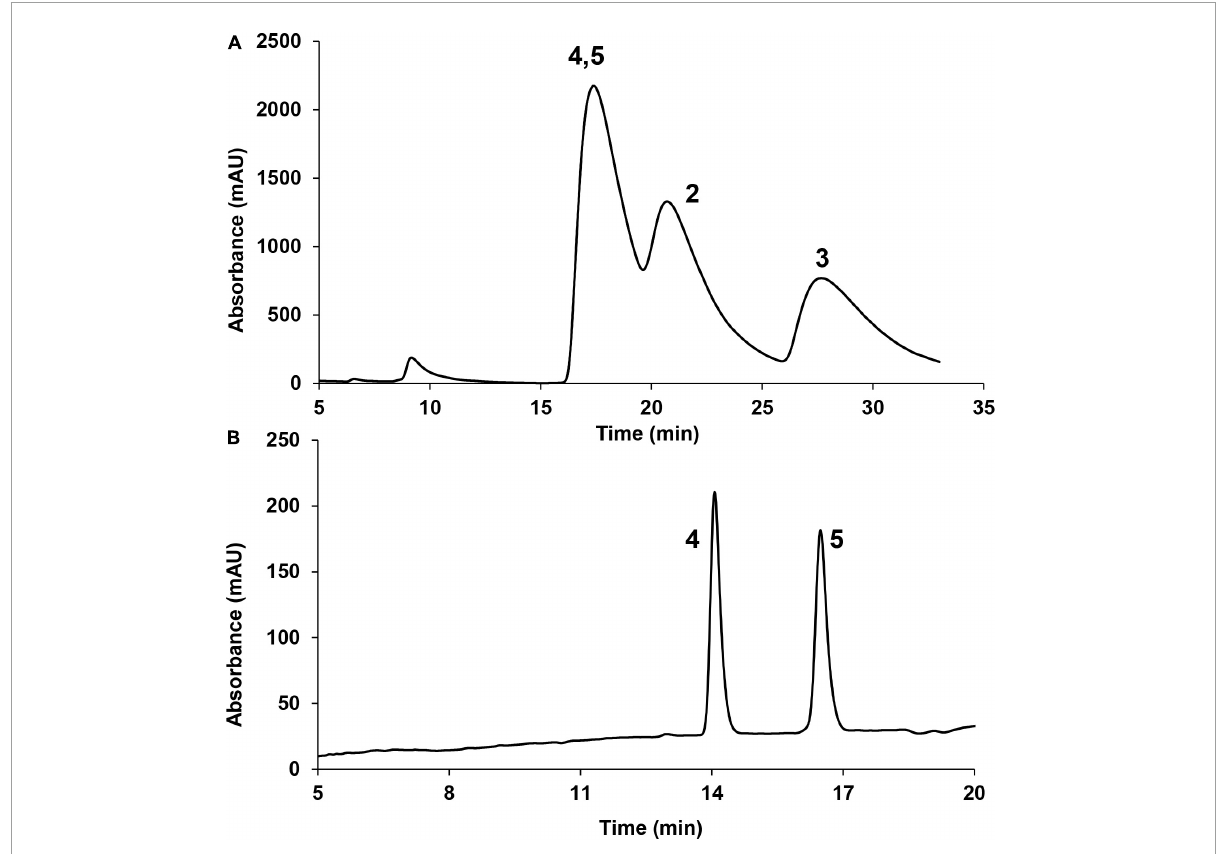
FIGURE3 Chiral phase HPLC analysis of compounds 2 – 5 (220 nm). (A) CHIRALPAK AS-H column; (B) CHIRALPAK AD-H